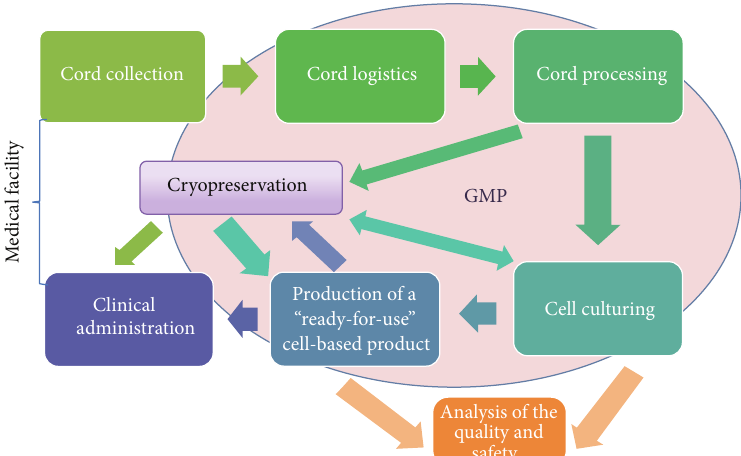
Figure 1: Schematic demonstration of the interconnections between the processes involved in obtaining of the product under GMP